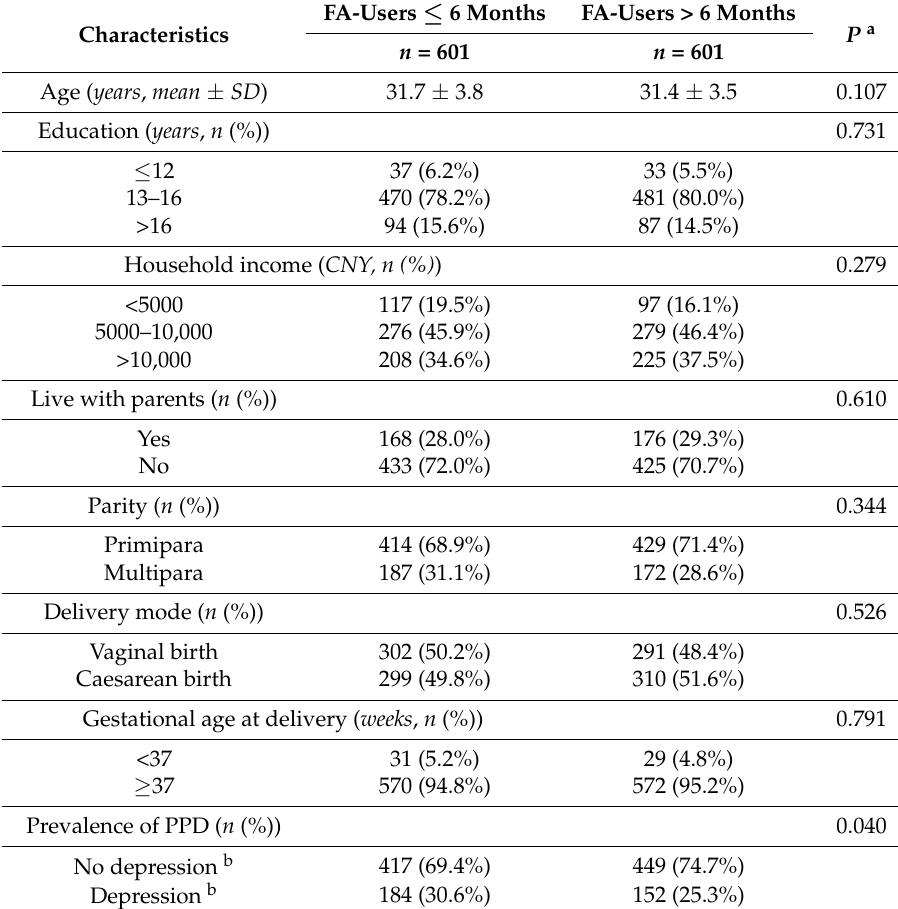
Table 2. Characteristics of study participants and prevalence of PPD according to the duration of FA supplementation after propensity matching ( n